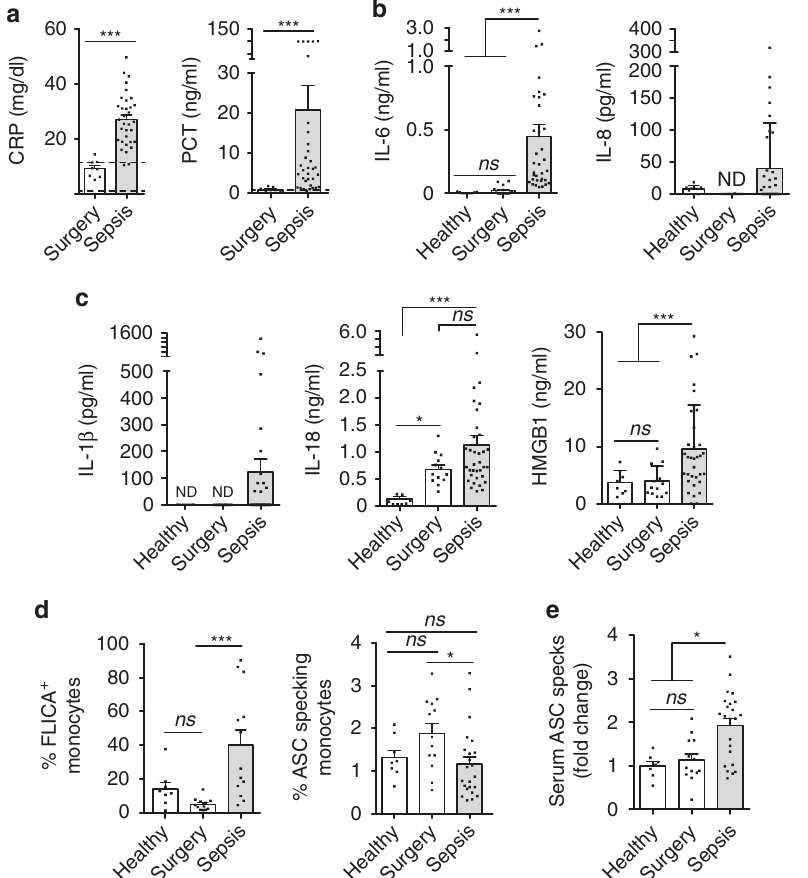
Fig. 1 Sepsis patients present with elevated in fl ammasome markers. a – c Plasma concentration of CRP, PCT a , IL-6, IL-8 b , IL-1 β , IL-18, and HMGB1 c in healthy controls, abdominal surgery patients within the fi rst 24 h after surgery and intra-abdominal origin septic patients within the fi rst 24 h of admission to the surgical critical unit; dotted lines in a represent standard threshold for CRP and PCT in healthy population. d Percentage of monocytes from healthy controls and septic patient positives for active caspase-1 labeled with FLICA (left) or positives for intracellular ASC specks (right). e Fold increase of circulating ASC specks in the plasma of surgery controls and septic patients compared with healthy controls. Each dot represents an individual patient; average ± standard error is represented in all panels; exact n number for each panel is presented in Source Data fi le; * p < 0.05; ** p < 0.01; *** p < 0.001; ns , no signi fi cant difference ( p > 0.05); Mann – Whitney test for a ; Kruskal – Wallis test for b –